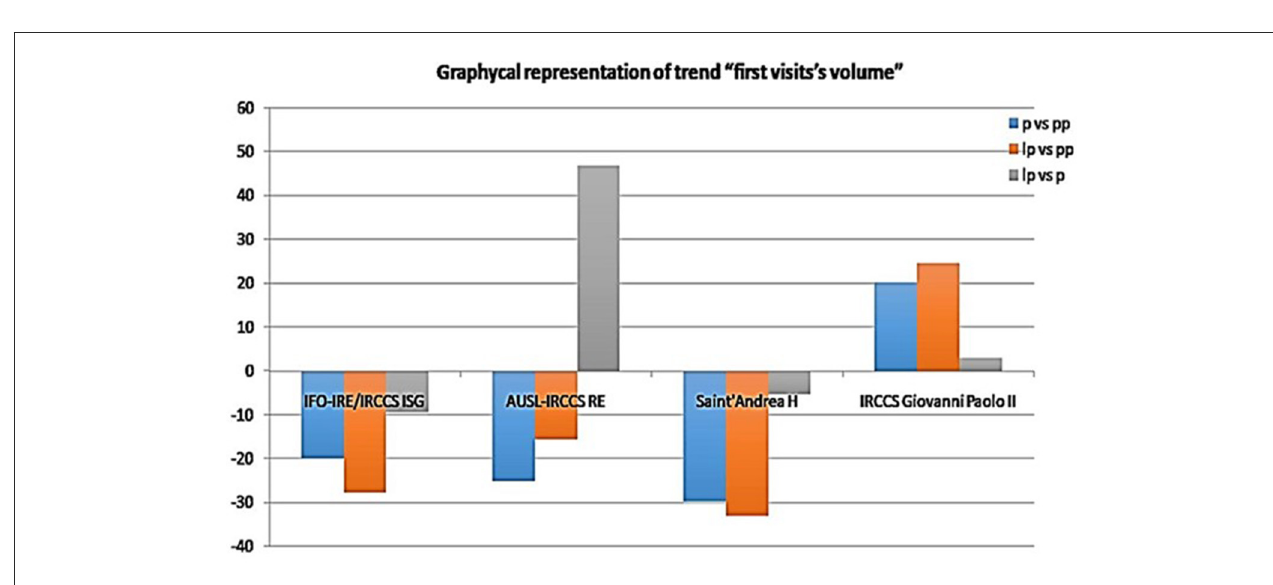
FIGURE8 Volume of initial visits over